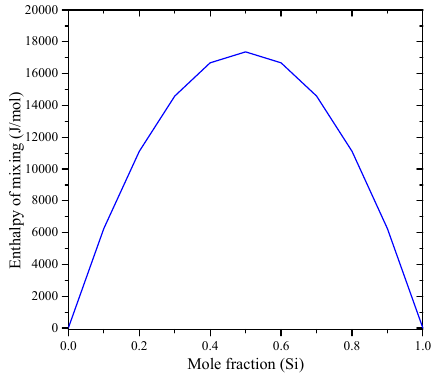
Figure 35. Calculated enthalpy of mixing of the Si-Tl liquid using thermodynamic coefficients from [120].